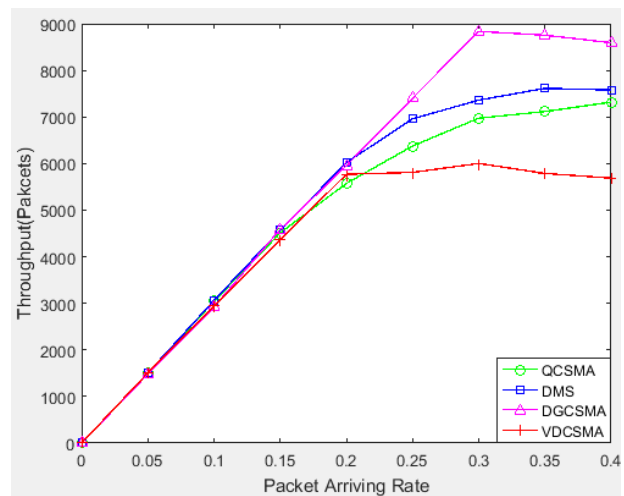
Figure 6. Throughput of non-real-time links: λ ∈ [ 0,0.4 ]